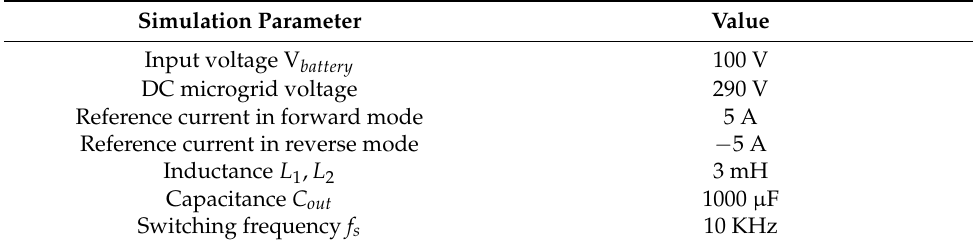
Table 1. Design parameters of DC–DC bidirectional